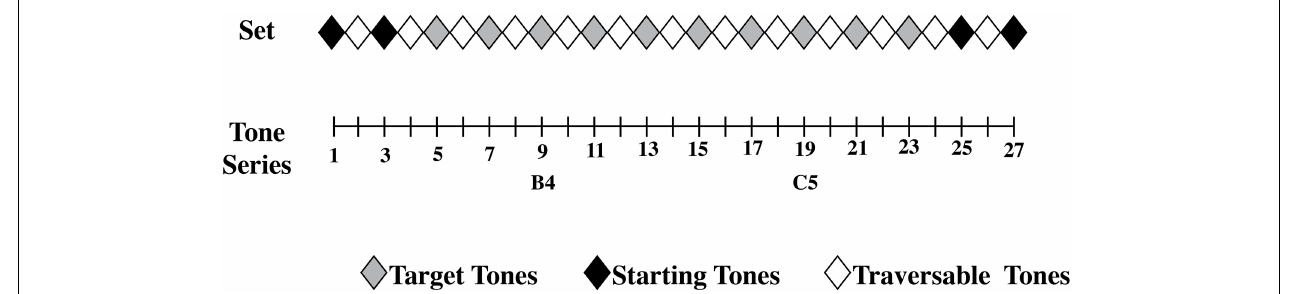
test tones. Stimulus 9 was a perfectly in-tune [B4] and stimulus 19 was a perfectly in-tune [C5]. Stimulus 14, between stimuli 9 and 19, marks the central item of the tested